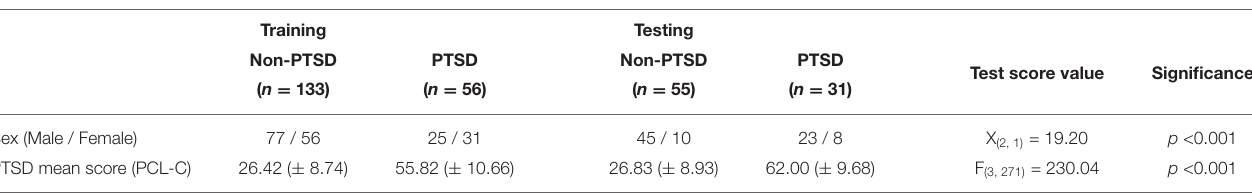
TABLE 3 | Demographics and outcome measures for 2017-to-2019 partitioning folds.